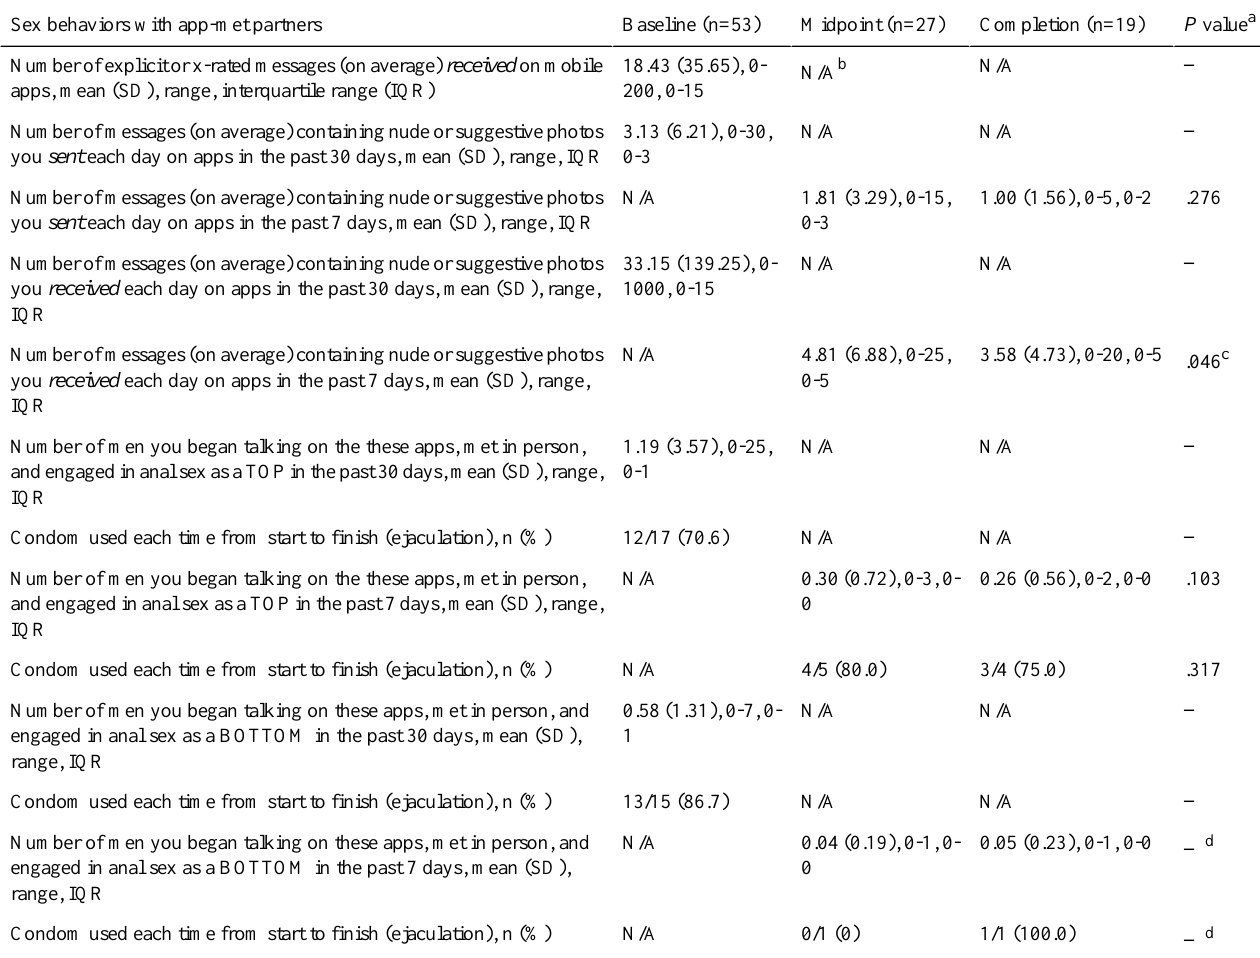
Table 4. Sex behaviors with app-met partners across three time periods among app-using men who have sex with